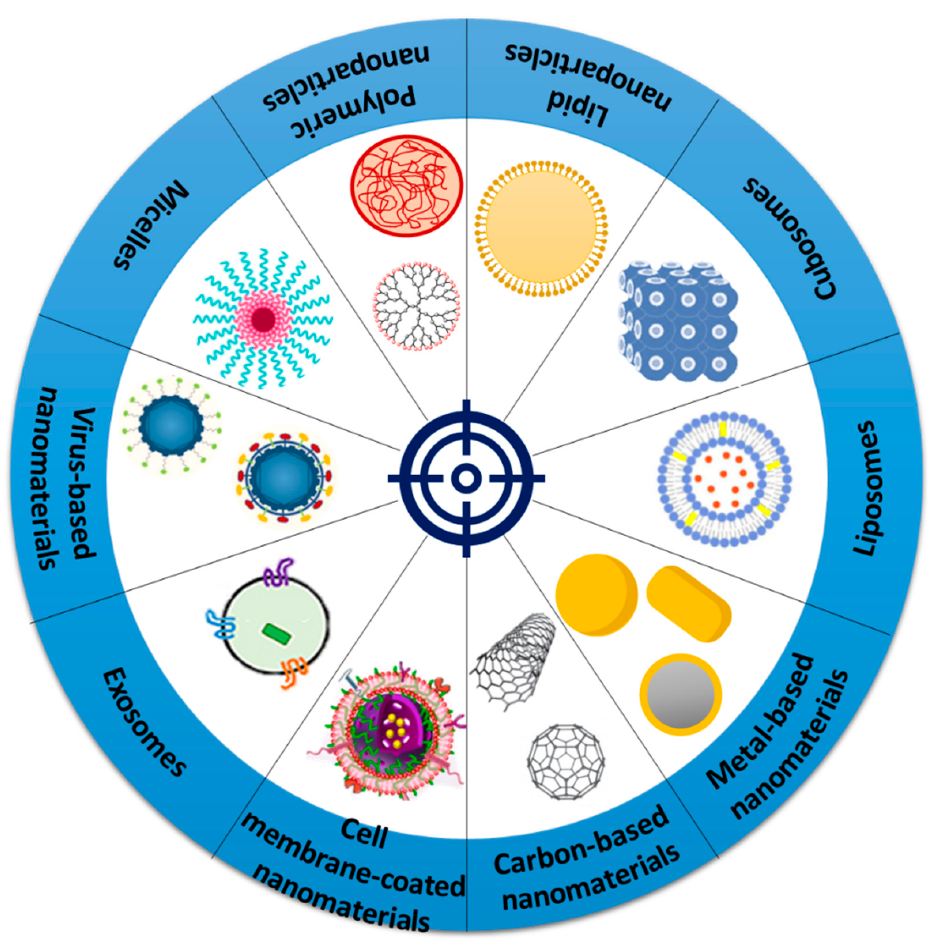
Figure 3. Schematic representation of various nanomaterials researched for tumor-targeting appli-